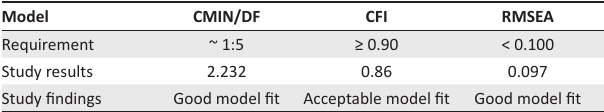
TABLE 7a : Model-fit and construct reliability distribution.